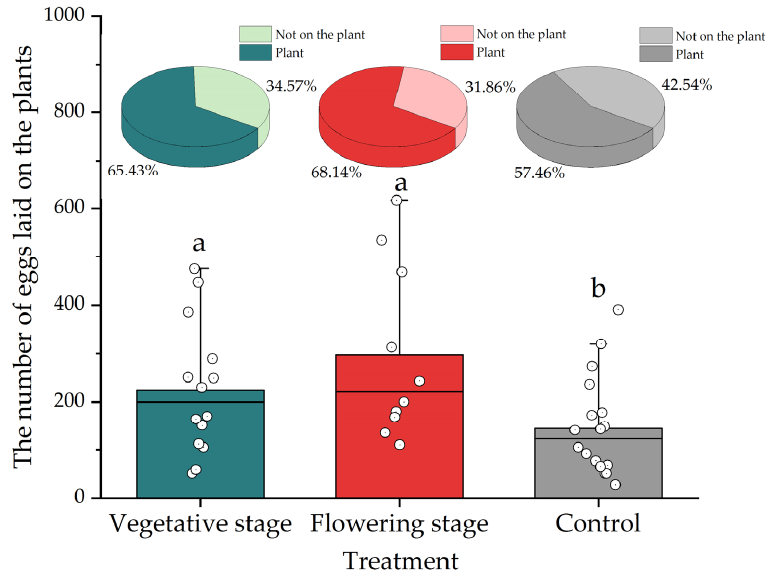
Figure 3. Effect of the Ocimum basilicum phenological stage on the number of Chrysopa pallens eggs that were deposited on plants, e.g., as compared to cage walls or pots. Results are shown for O. basilicum vege- tative and flowering stages, as compared to the control treatment. Different letters indicate statistically significant differences between treatments (ANOVA, Fisher’s LSD test for mean separation, p < 0.05).